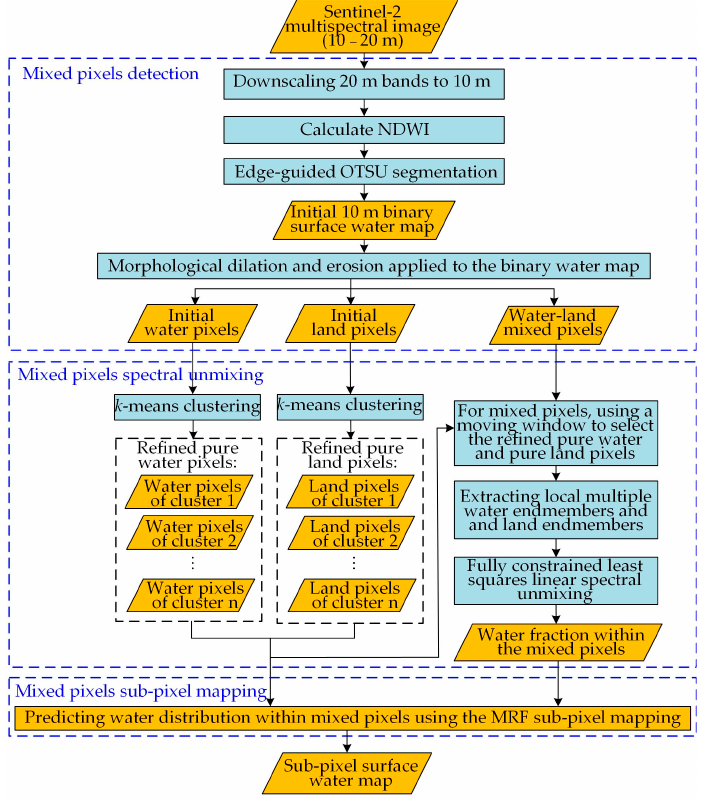
Figure 1. Flowchart of the proposed sub-pixel surface water mapping method.